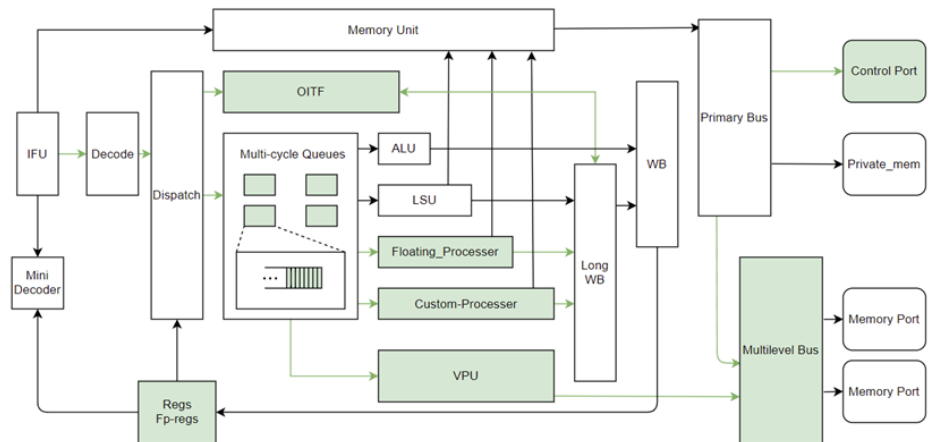
Figure 2. The overall hardware architecture diagram. Additional designs are marked in green color.